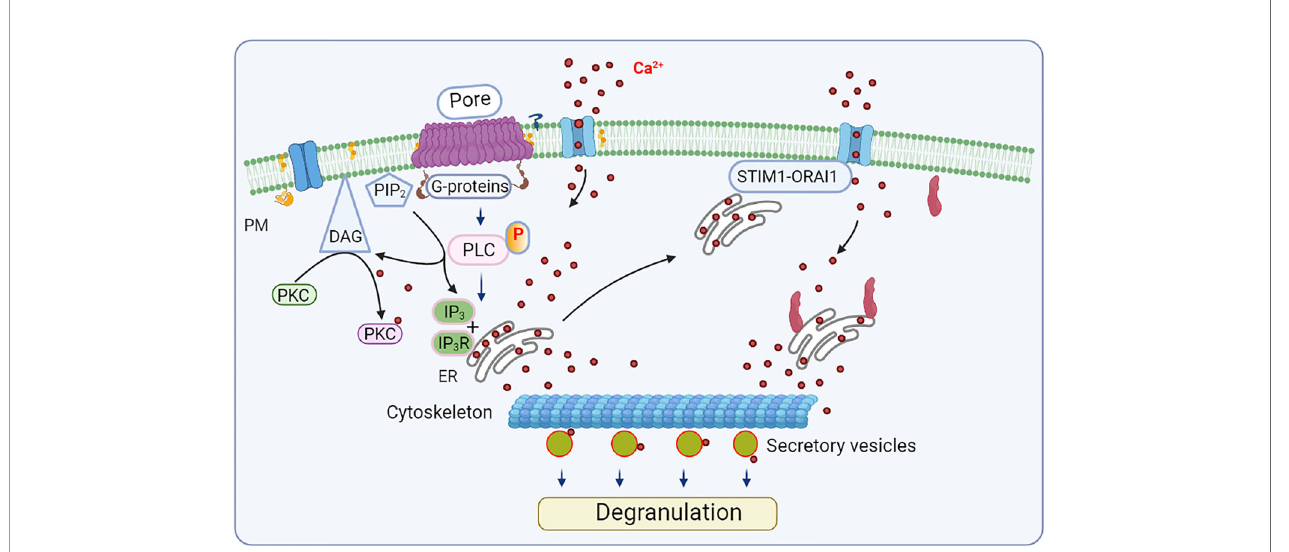
FIGURE 3 | Mast cell activation by CDCs - calcium response and degranulation. Exposure of mast cells to sublytic concentrations of CDCs leads to aggregation of lipid rafts and transmembrane insertion of CDC complexes, resulting in phosphorylation of signal transduction molecules, including phospholipase C (PLC). PLC hydrolyses PM-localized phosphatidylinositol 4,5-bisphosphate (PIP2), producing inositol-1,4,5-trisphosphate (IP3) and diacylglycerol (DAG). IP3 binds to IP3 receptor (IP3R) on the endoplasmic reticulum (ER), where it stimulates the release of calcium into the cytoplasm. Free cytoplasmic calcium together with DAG activates protein kinase C (PKC). The reduced Ca 2+ level in ER is sensed by stromal interaction molecule 1 (STIM 1), which then binds to and activates the store- operated ORAI1 calcium ion channel in the PM. Calcium could also be released due to the injury of intracellular Ca 2+ stores by CDCs. Increased levels of free cytoplasmic Ca 2+ and other activation events lead to the release of secretory vesicles (degranulation) in which the cytoskeleton plays an important